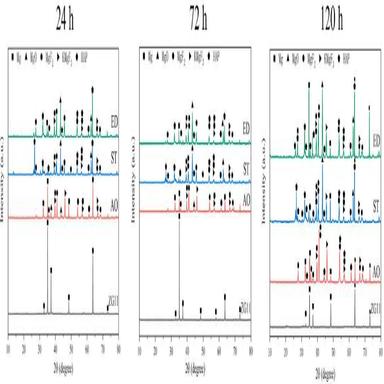
XRD patterns of ZG11 alloy and three prepared samples during immersion in SBF for 120 h.